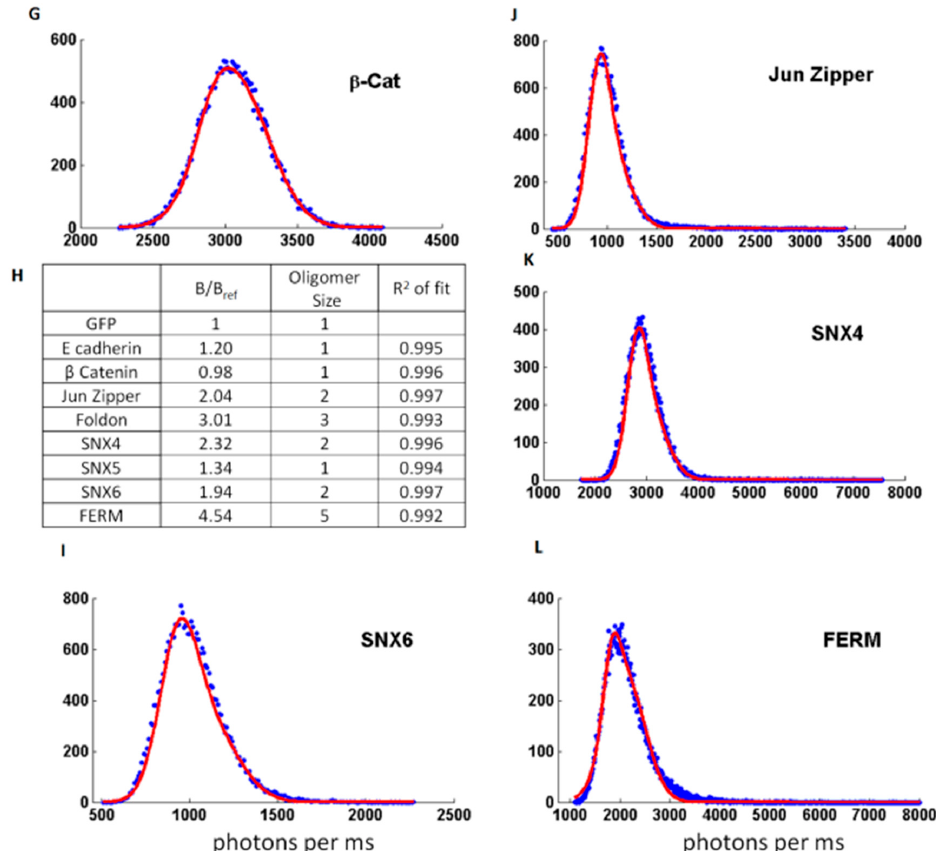
Figure 4. ( A , B ) Typical fluorescent time traces used for brightness analysis, obtained for GFP ( A ) and GFP-foldon ( B ). The background fluorescence are similar (~400 photons/ms) but the amplitude of the fluctuations are bigger for GFP-foldon than for GFP; ( C ) Histogram showing the number of events corresponding to different fluorescence intensity values (photons per ms or cpms) measured in the time traces shown in ( A ) and ( B ) for GFP (light grey) and GFP-foldon (black). The distribution for GFP-foldon (black) is larger than GFP (light grey); ( D – L ) Example of different distribution of values for different proteins for which the oligomerization status was previously described using other techniques. In blue are the experimental data and red is the calculated Gaussian fit; ( H ) Table presenting the calculated oligomeric status of the protein based on brightness analysis (“B/B ref ”) compared to the literature (“oligomer size”) and accuracy of the fit (“R 2 of fit”).